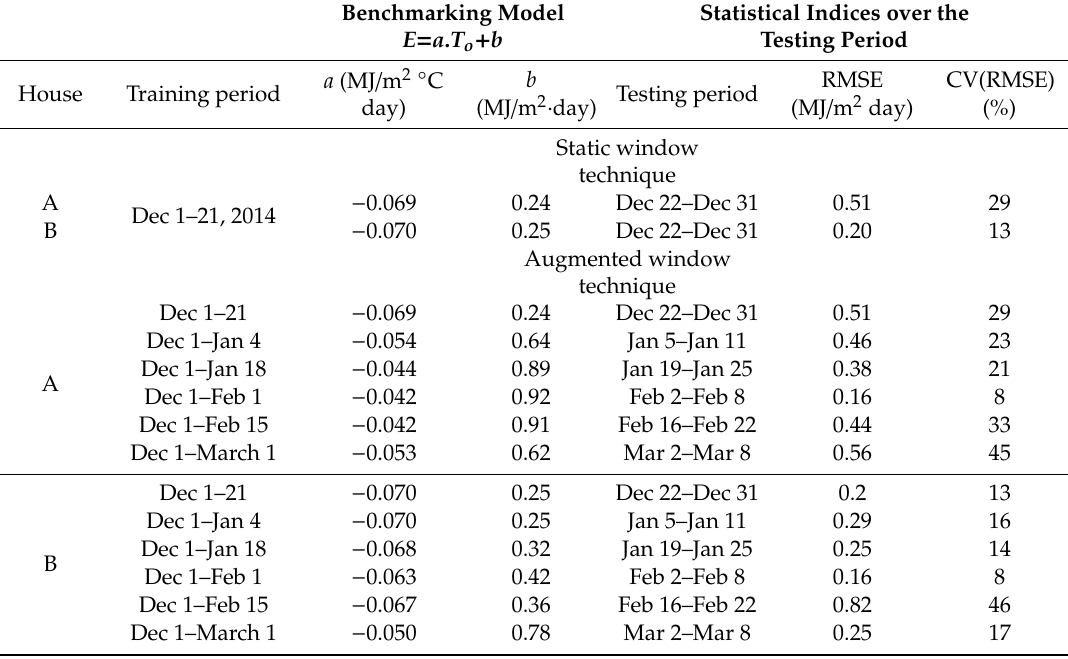
Table 3. Coe ffi cients of the trained benchmarking models, and statistical indices of the di ff erence between measurements and predictions over the testing